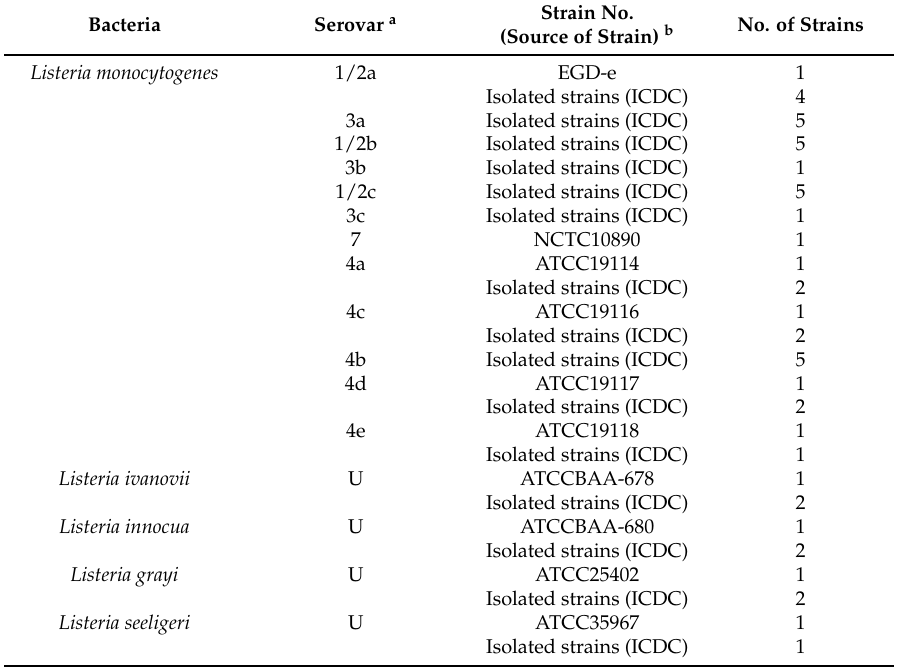
Table 3. Bacterial strains used in the